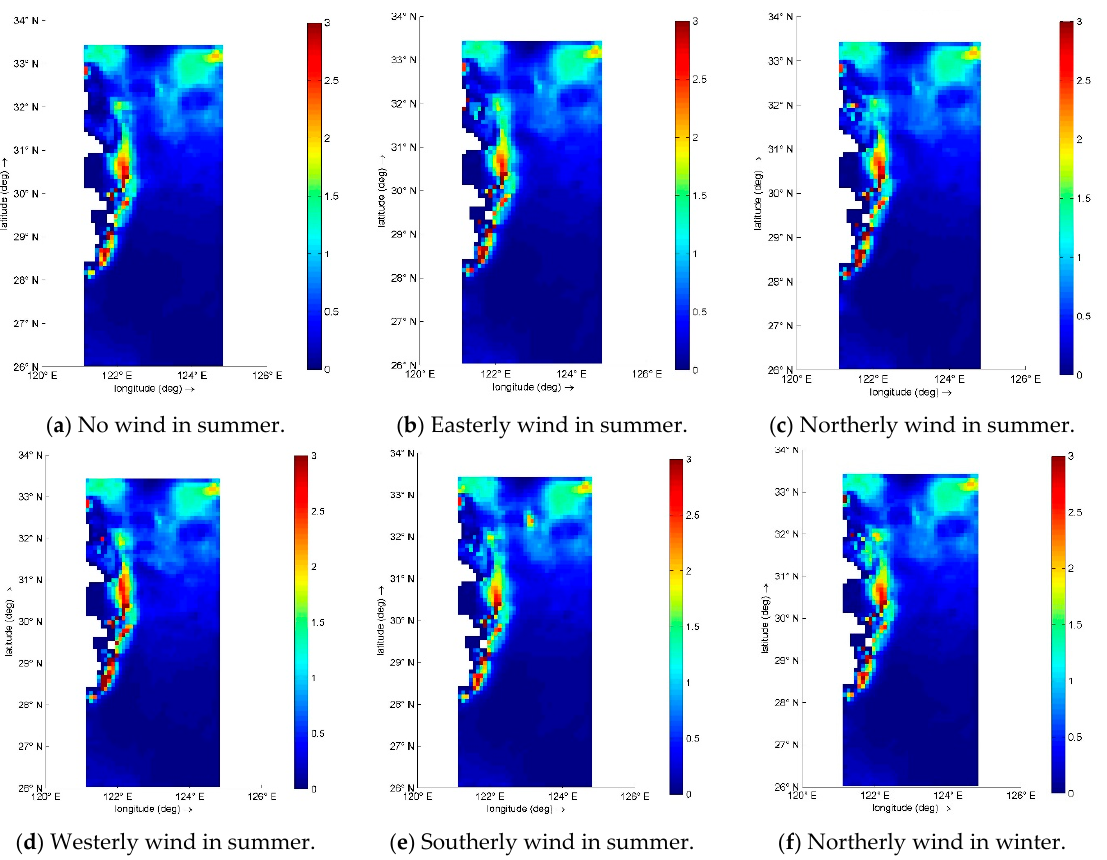
Figure 14. The shear stress on the bottom bed of the Yangtze River delta under no wind ( a ), easterly wind ( b ), northerly wind ( c ), westerly wind ( d ), and southerly wind ( e ) in summer and northerly wind ( f ) in winter (unit: Pa).